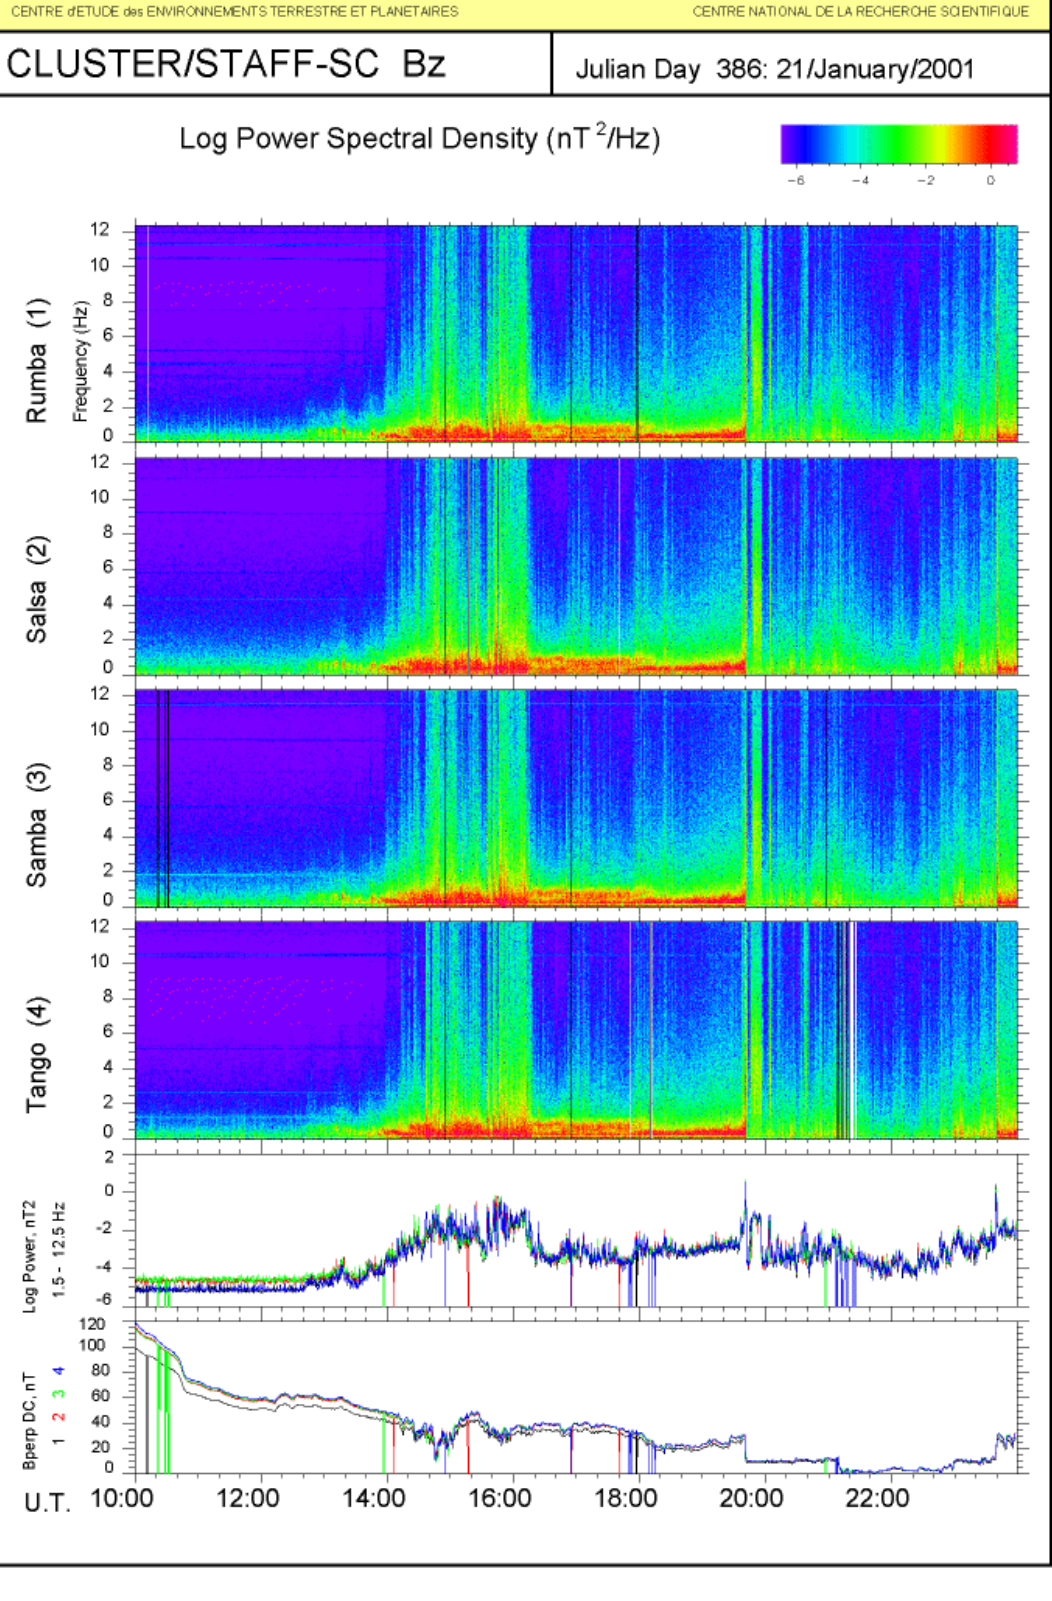
Fig. 6. The low frequency (0.1–12Hz) dynamic spectra for the same time interval as in Fig. 5 for the four spacecraft. For the presentation, see Fig.